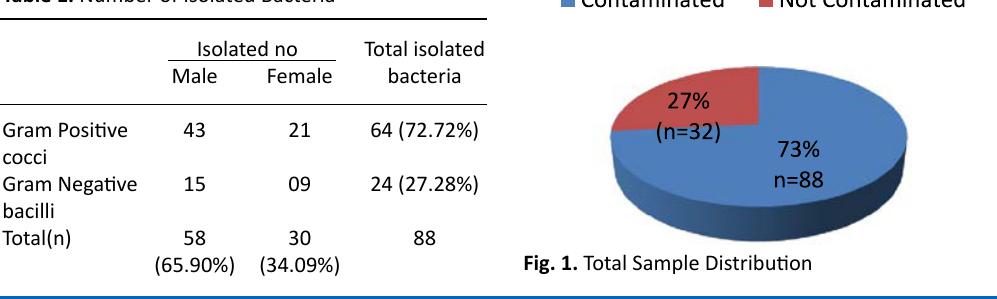
Fig. 1. Total Sample Distribution